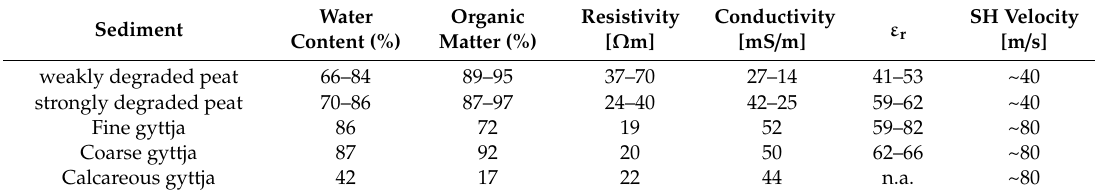
Table 1. Properties of the peats and gyttjas deposits delivered from this